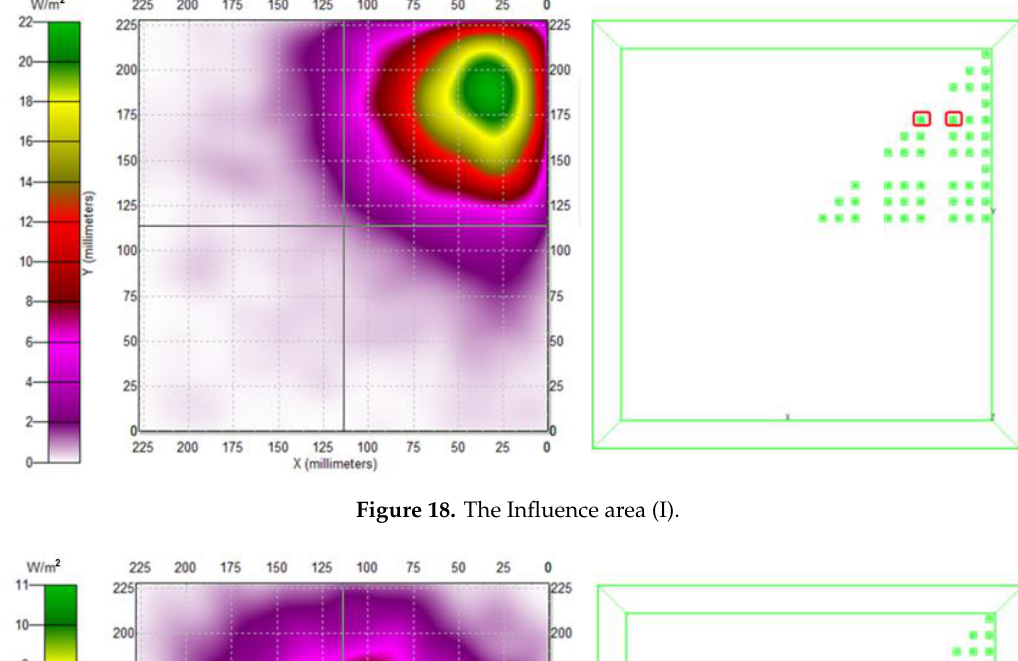
Figure 18. The Influence area (I).